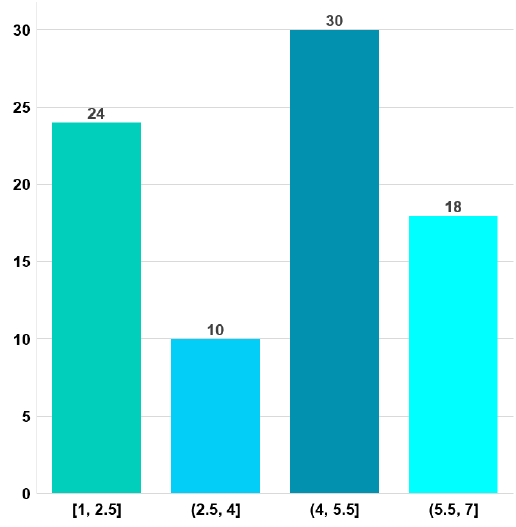
Figure 4. Evaluation of serious games with CCA and PEAT. Table 3. Summary of Accessibility Evaluation in Serious Games with the Manual